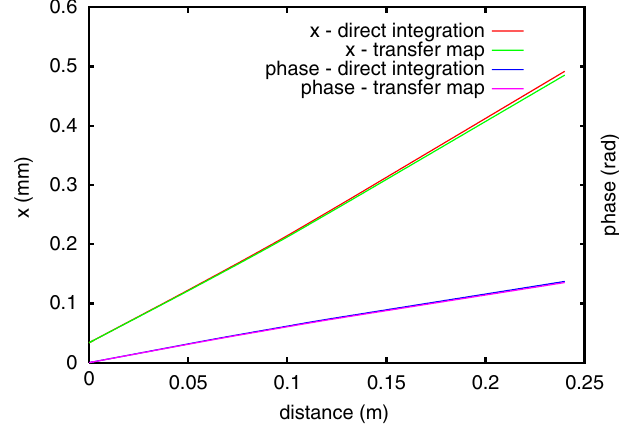
FIG. 1. (Color) Horizontal and longitudinal trajectories through an rf cavity from the linear transfer map and from direct numerical